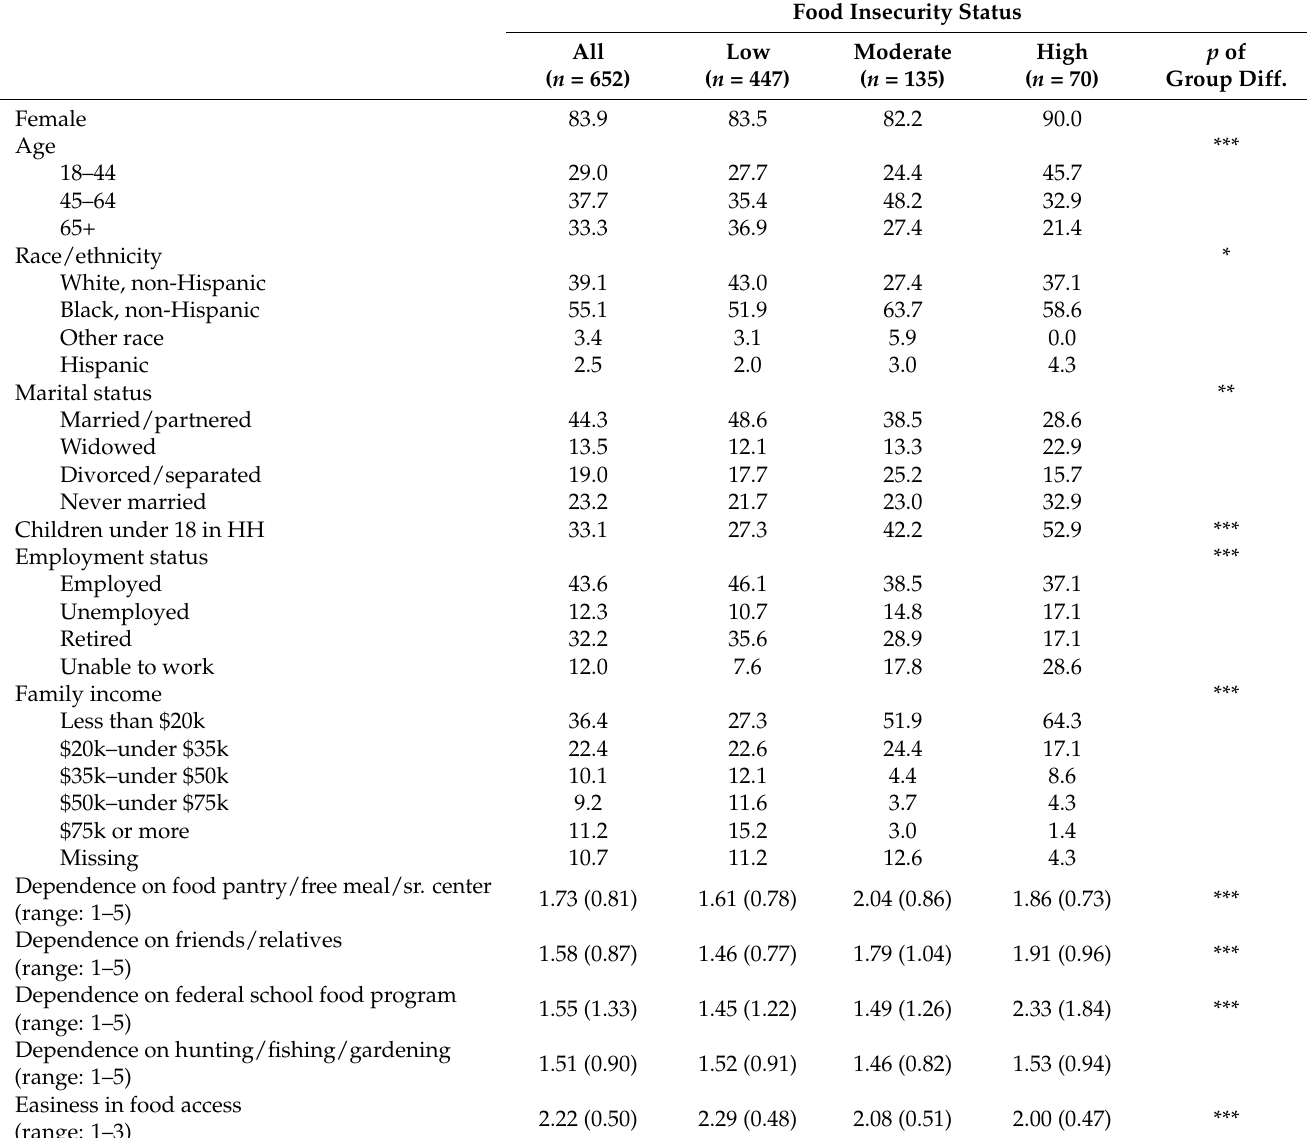
Table 1. Descriptive statistics for all and by food insecurity